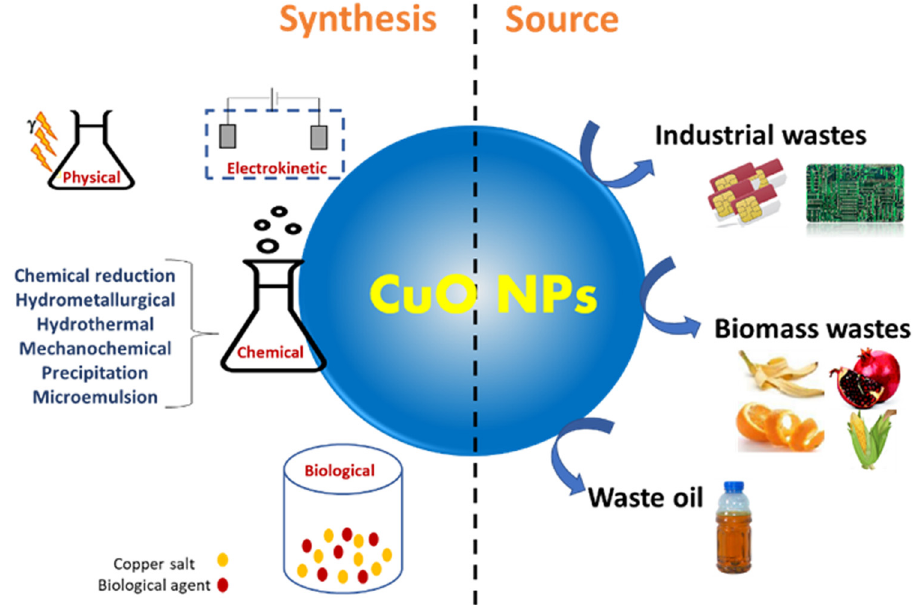
Figure 11: An illustration of the green synthesis of CuO NPs from waste materials by di ff erent physical, chemical, and biological